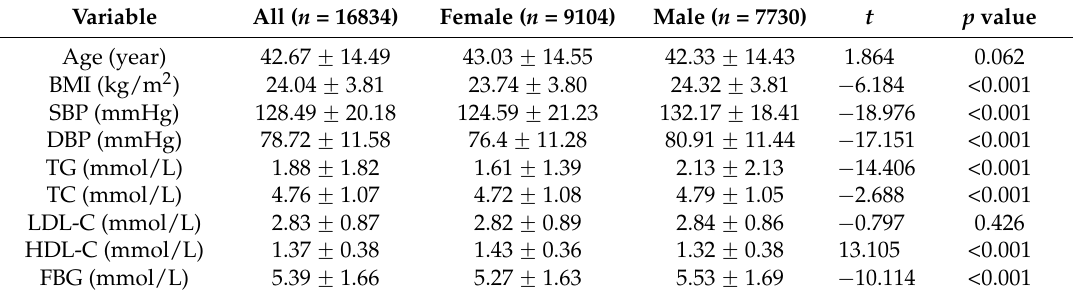
Table 1. Descriptive characteristics of participants by gender for